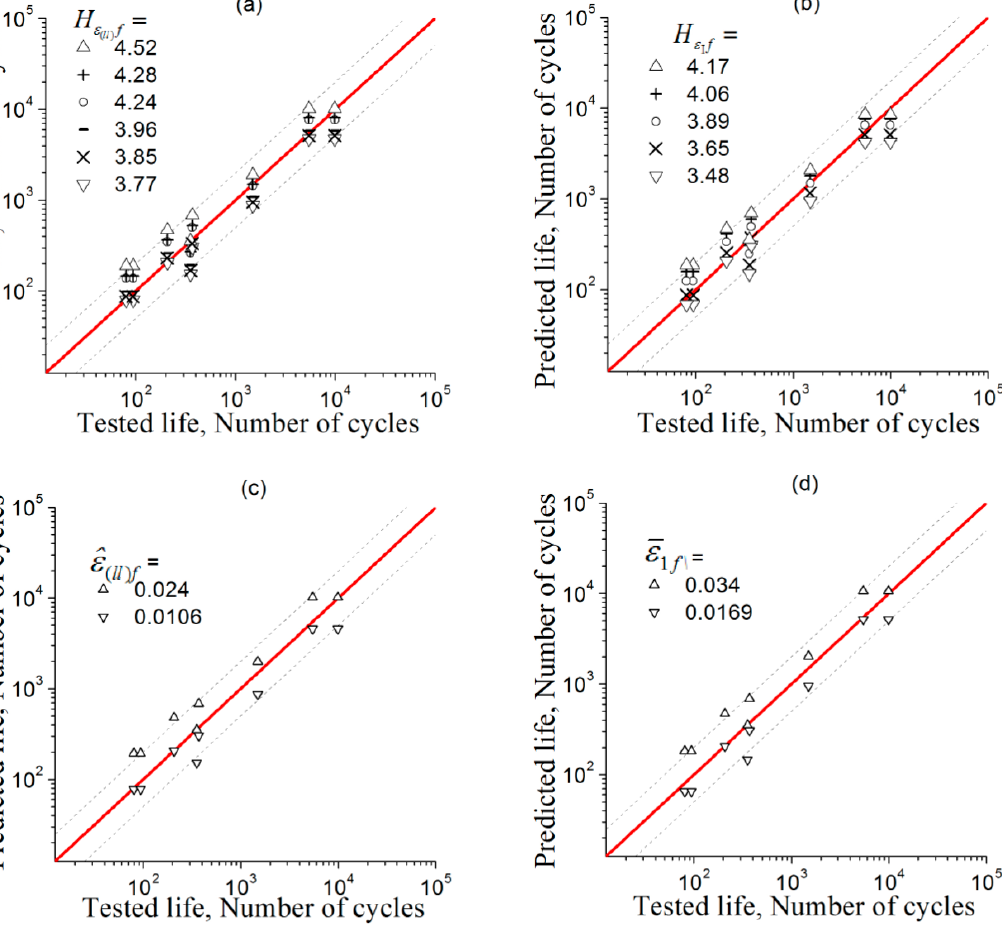
Figure 10. Comparison between predicted fatigue lives with various FIPs and test data of GH4169, the predictions respectively based on: ( a ) H ε